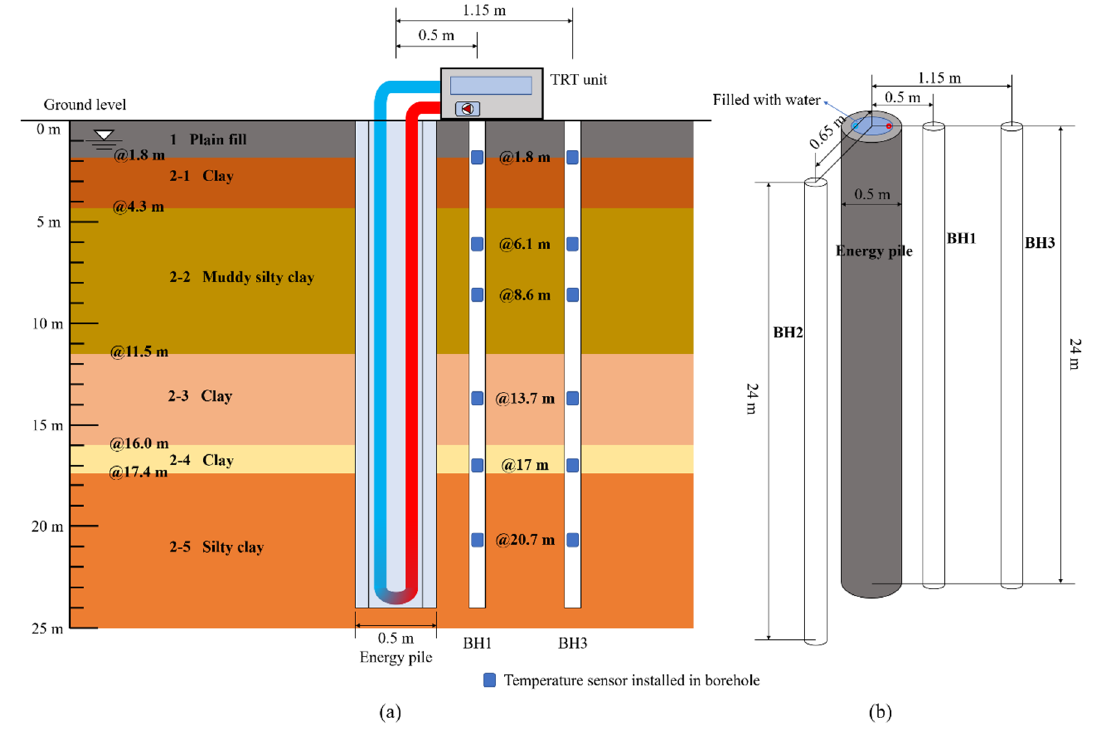
Figure 3. ( a ) Arrangement of sensors in the boreholes; ( b ) layout of three ground temperature monitoring boreholes.